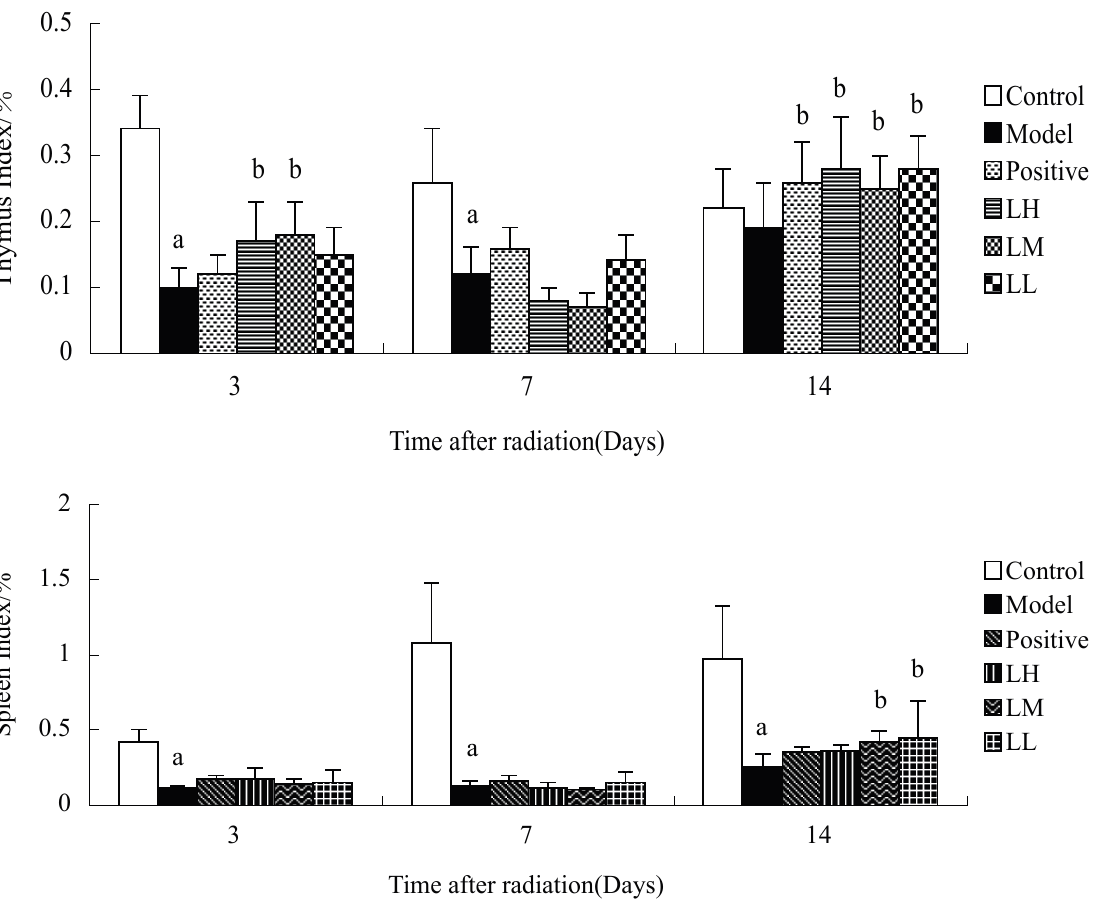
Figure 4. Effect of Lycium ruthenicum Murr. on the index of thymus and spleen of mice after Radiation. n =10, mean ± SD. a p < 0.05 vs. control group, b p < 0.05 vs. model